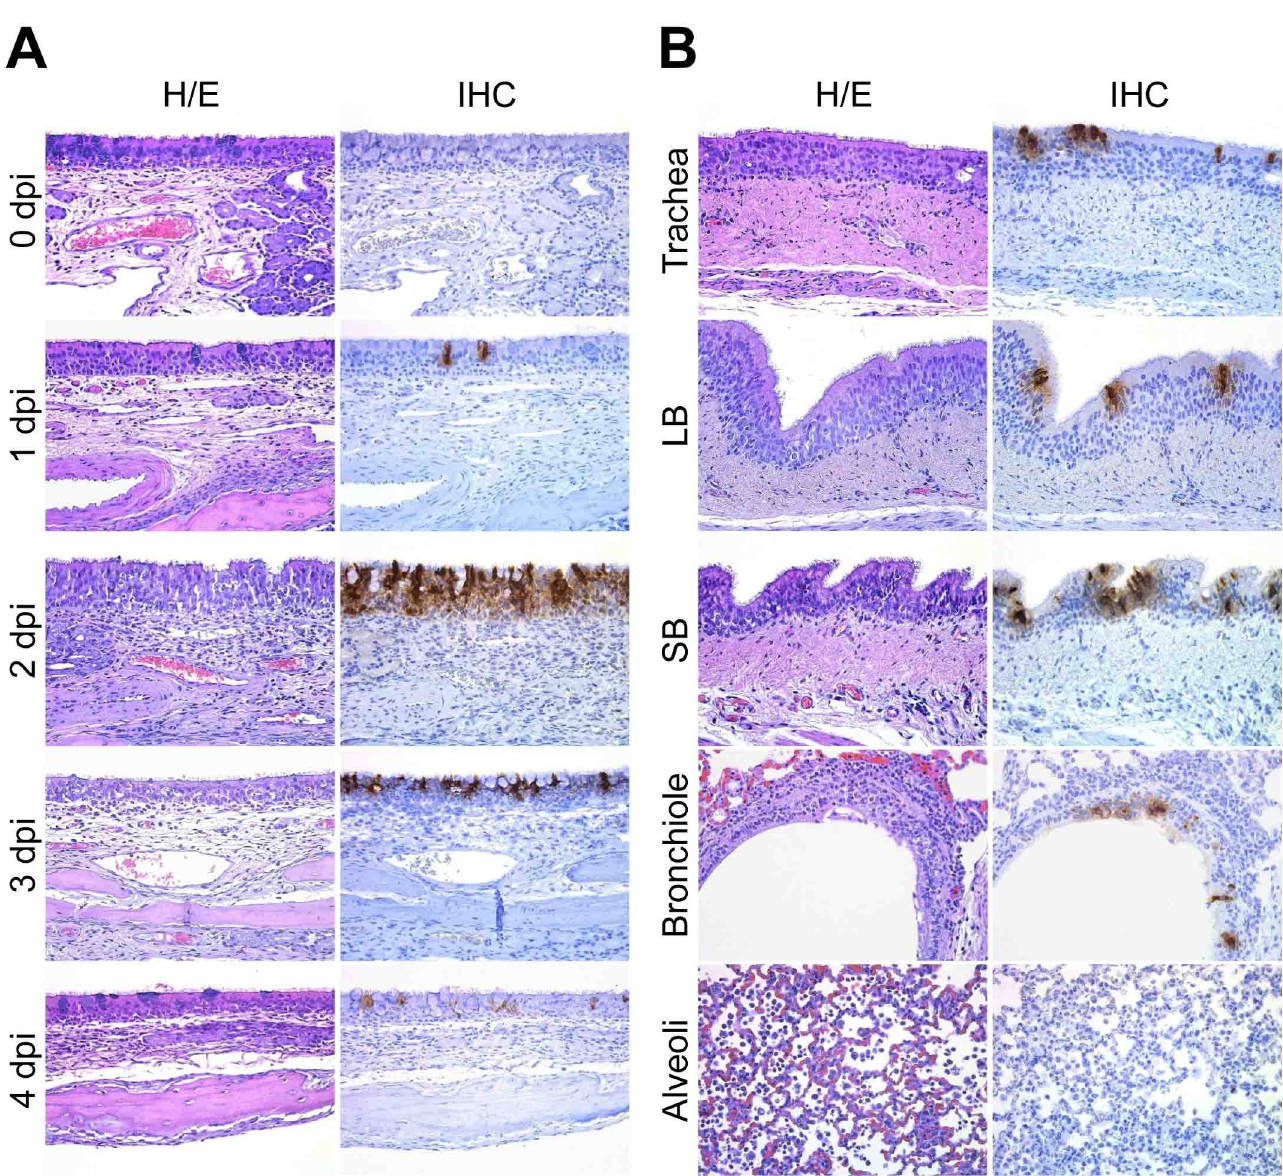
Fig 2. Histopathological changes and viral detection in respiratory tracts of alpacas inoculated with MERS-CoV. All respiratory tissues were fixed in 10% neutral-buffered formalin. (A) Nasal turbinate tissue sections of alpacas from the non-infected group (0 dpi), and from those necropsied on1 to 4 dpi. (B) Tissue sections of trachea, bronchus and lung (bronchiole and alveoli) from infected alpacas at 2 dpi. Original magnification: × 400 for all tissues. See S1 Table for the detailed distribution of MERS-CoV antigen (N protein) in respiratory tracts. Abbreviations: H/E, hematoxylin and eosin stain; IHC, immunohistochemistry; LB, large bronchus; SB, small bronchus.